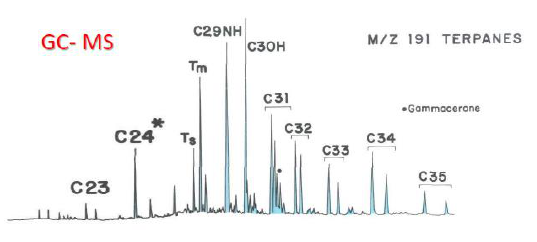
Figure 2. A representative m/z 191 chromatogram of a Turkish crude oil. Each peak on this chromagram is a biomarker molecule ratios of which is the part of the geochemical data matrix of this study.